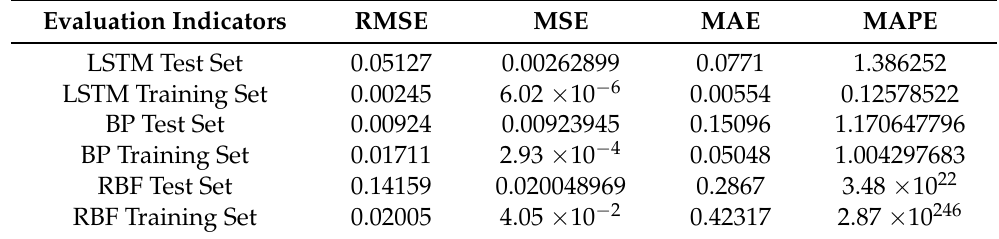
Table 3. List of model performance